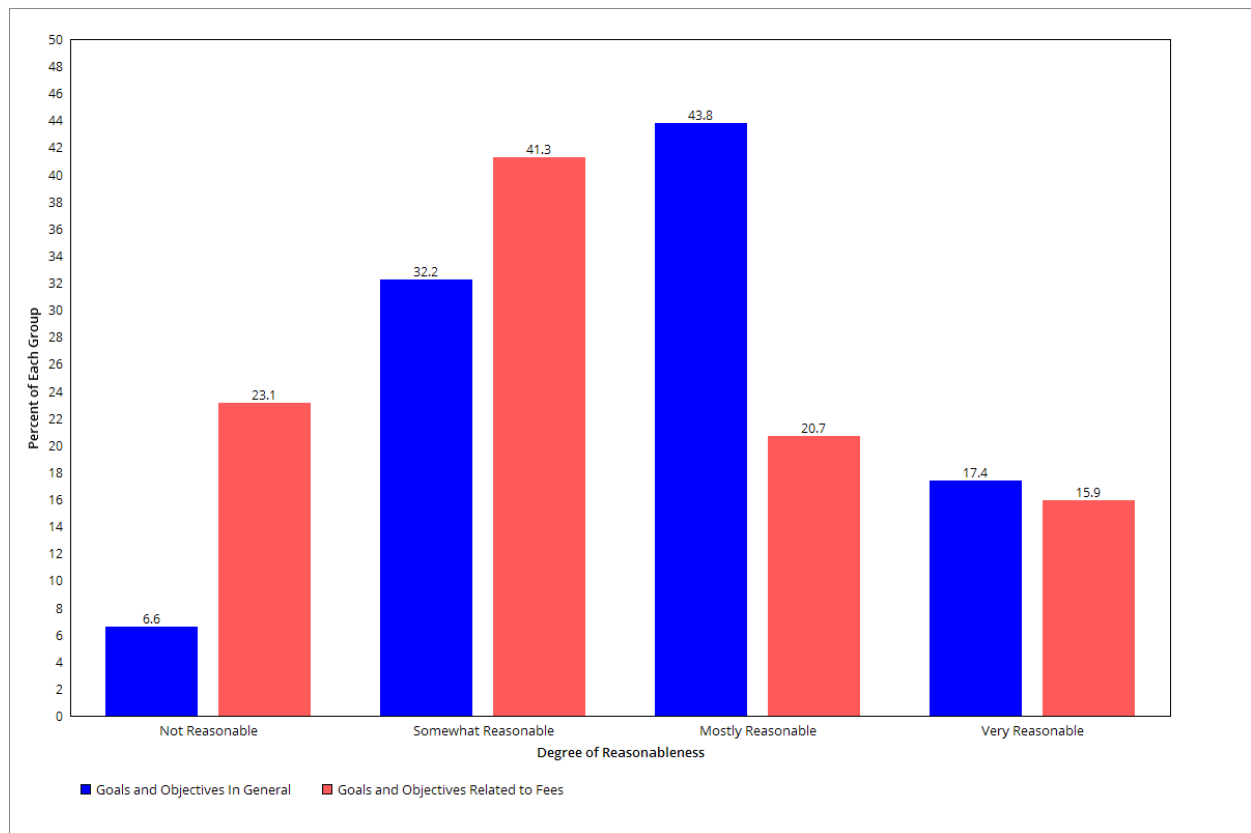
Figure 1. Respondent Attitudes Toward Goals and Objectives for Supervisees (N = 121).